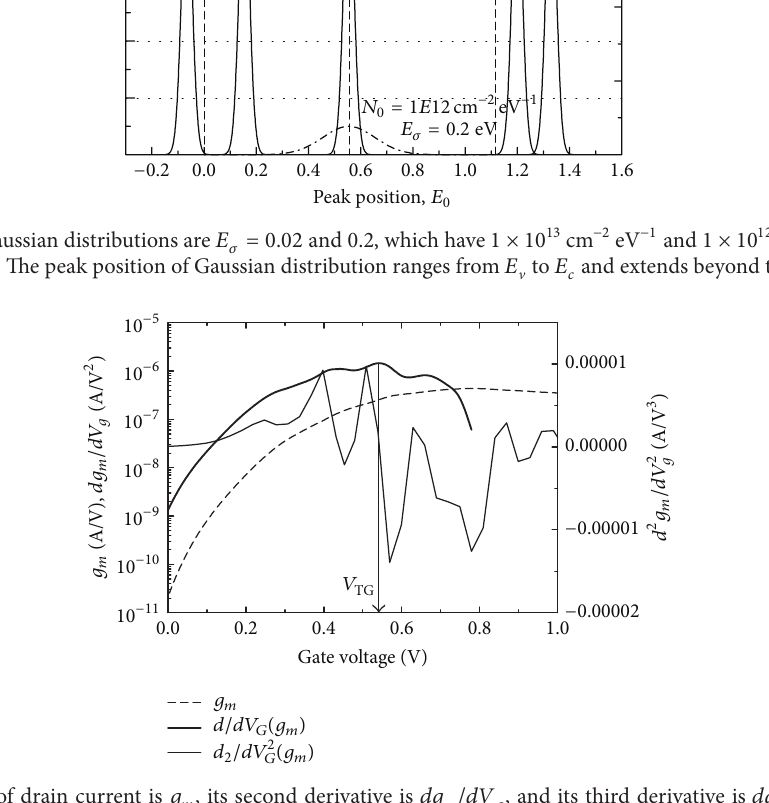
Figure 3: First derivative of drain current is 𝑔 𝑚 , its second derivative is 𝑑𝑔 𝑚 /𝑑𝑉 𝑔 , and its third derivative is 𝑑𝑔 2 𝑚 /𝑑𝑉 2 𝑔 ; 𝑉 channel length is 50